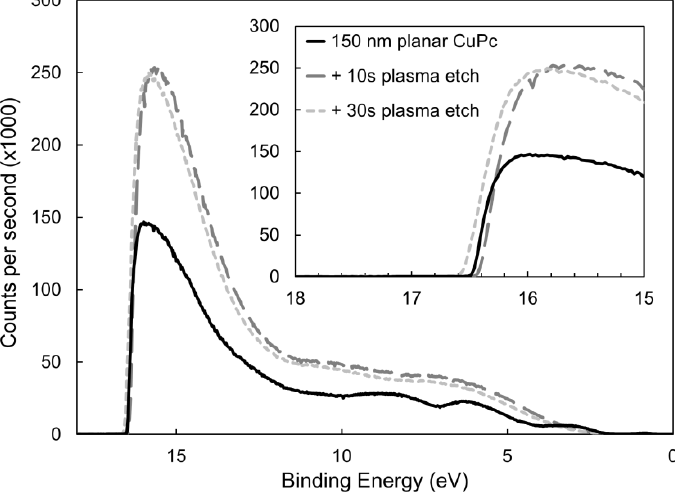
Figure 5. Changes to the UPS spectra of a planar CuPc film due to argon plasma etching.